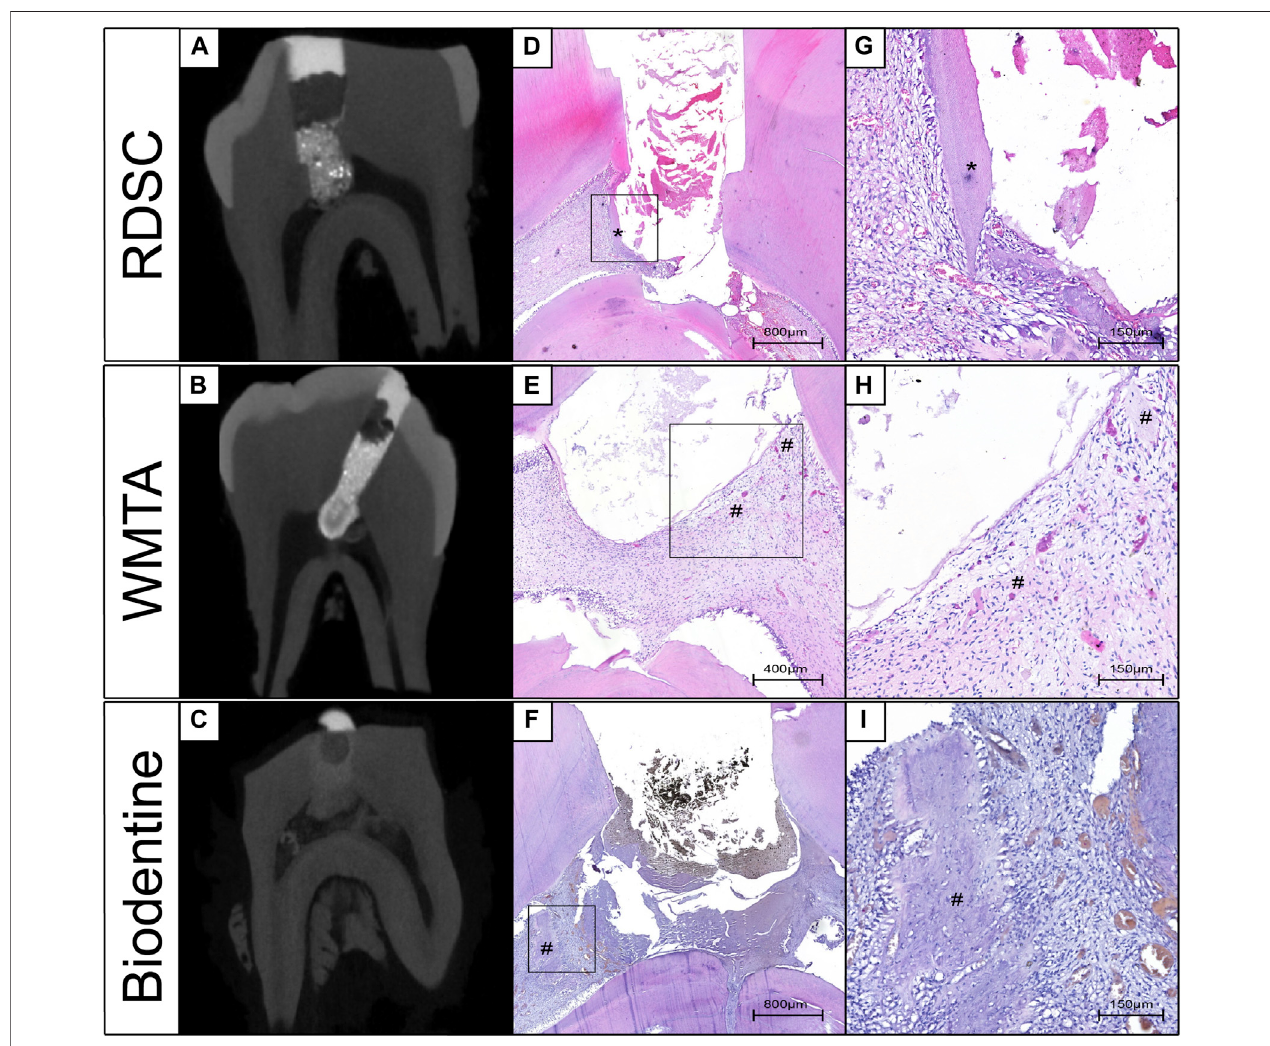
FIGURE 7 | Corresponding photographs of Micro-CT and histological assessments in the 7 days in-vivo miniature pig model. The high-intensive area in RDSC groups is the residual dentin (A,D,G) . Accumulation of cells and collagen fi bers was noted at the high-intensive area of WMTA and Biodentine groups (B – F,H,I) (*: residual dentin, #: Accumulation of cells and collagen fi